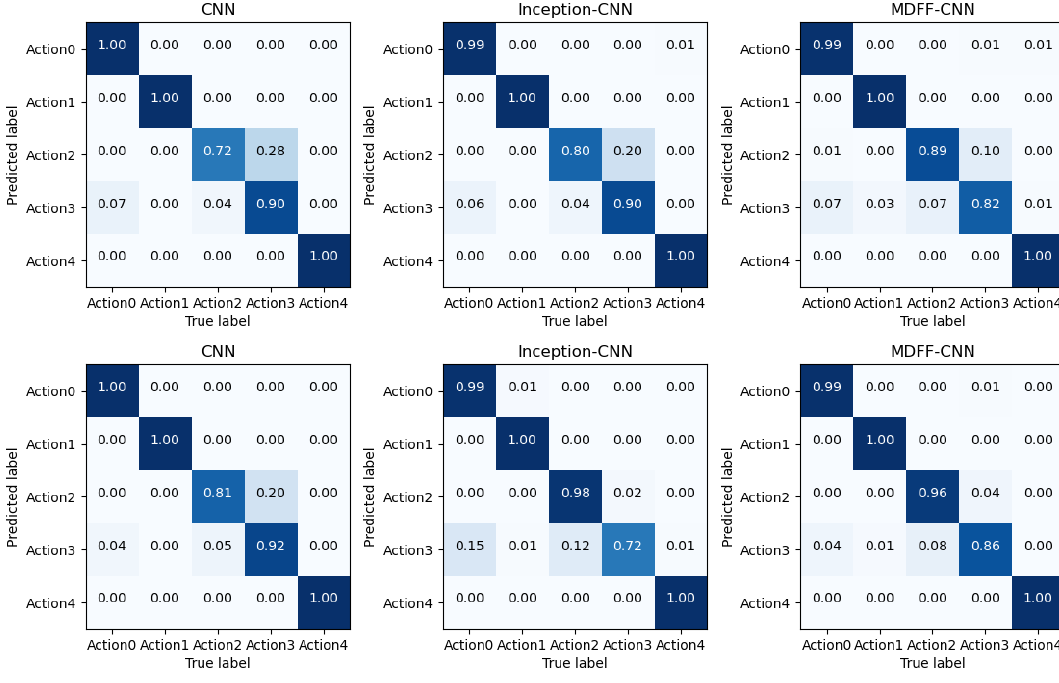
Figure 16. Convolutional neural network model recognizes the result confusion matrix diagram on the professional test set.